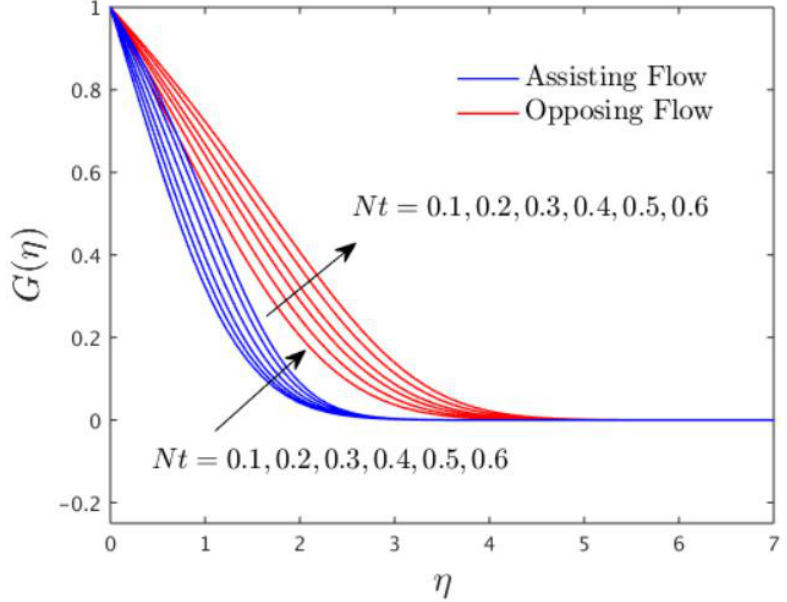
Figure 8. G ( η ) against Nt Figure 8.   G  against Nt .